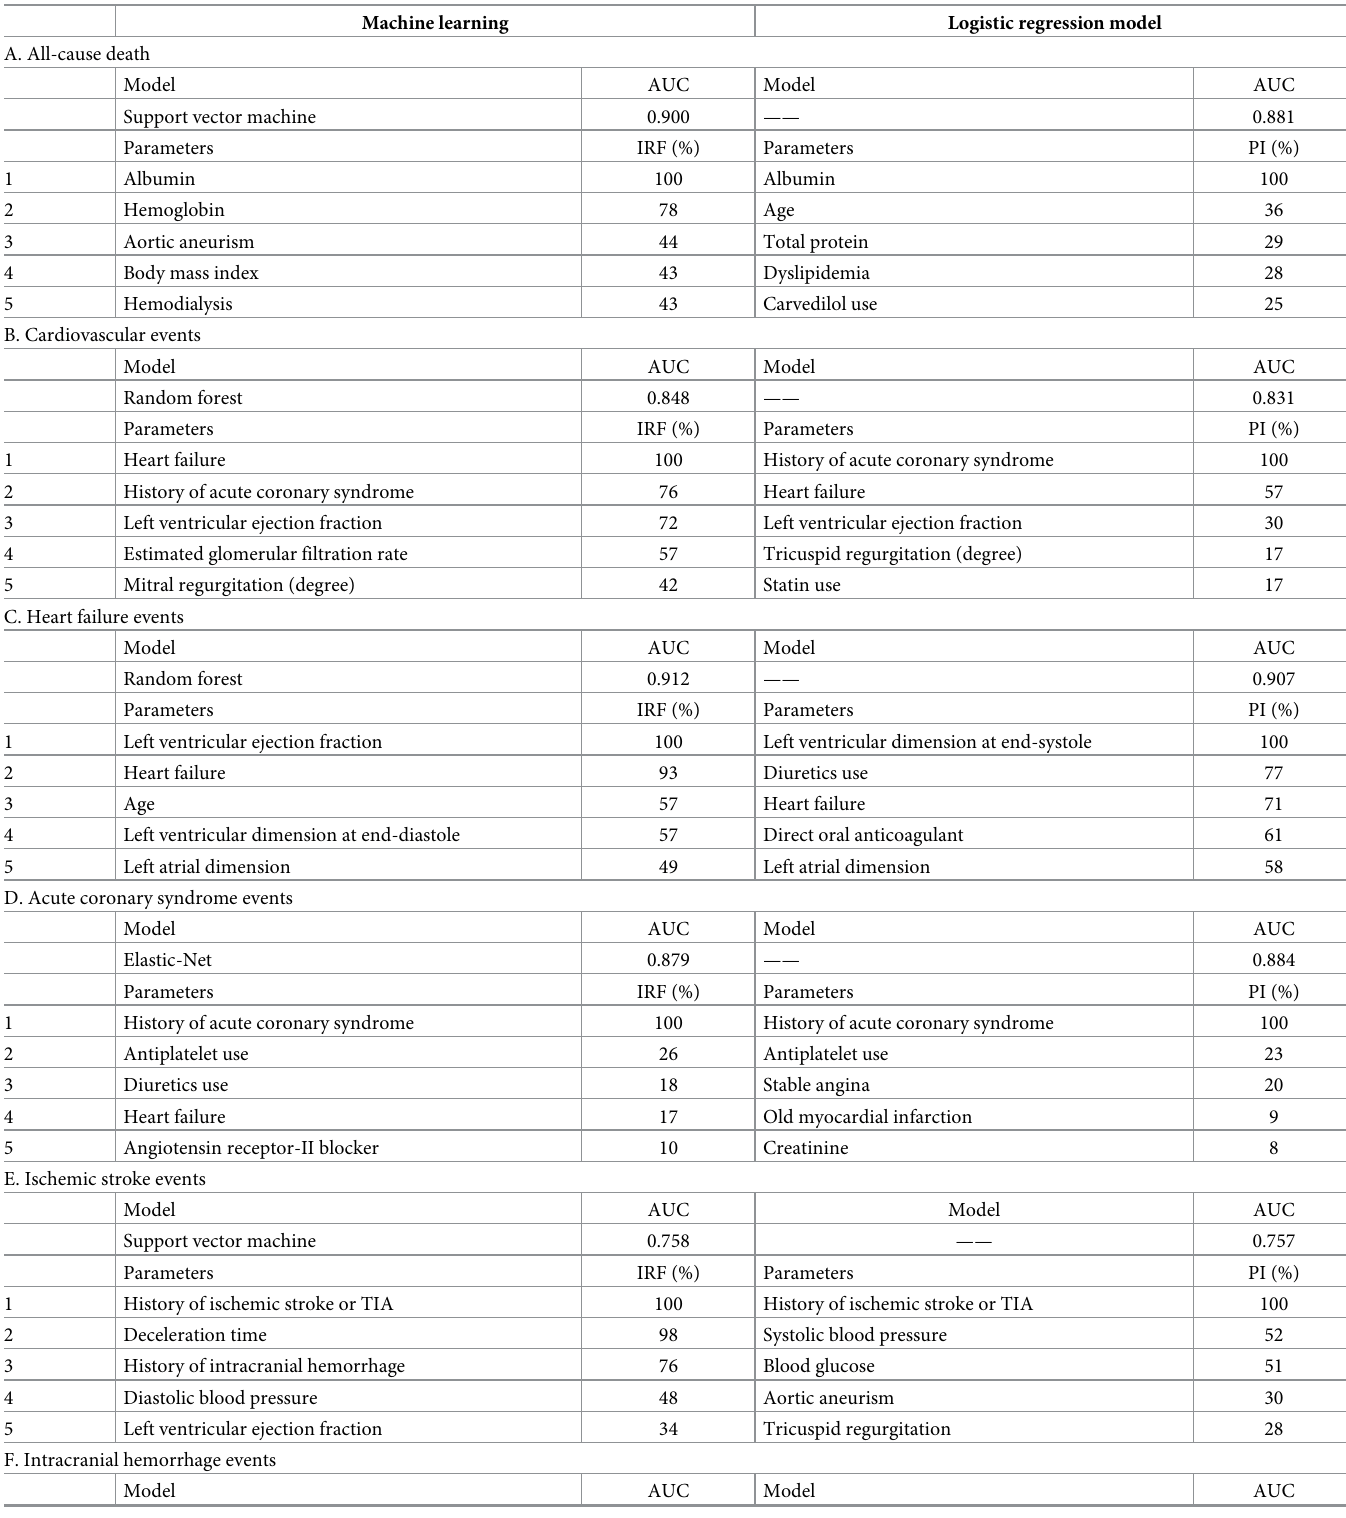
Table 4. Top five parameters for patient